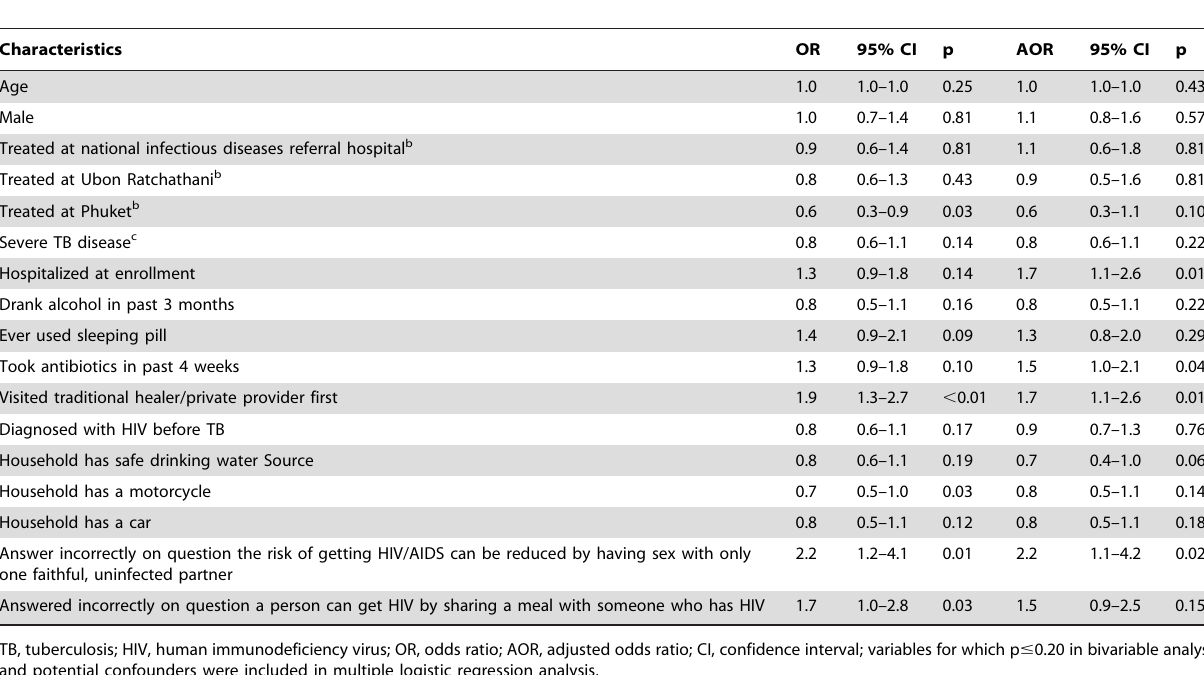
Table 3. Bivariable and multiple logistic regression analyses of predictors for having high TB stigma a among HIV-infected TB patients.